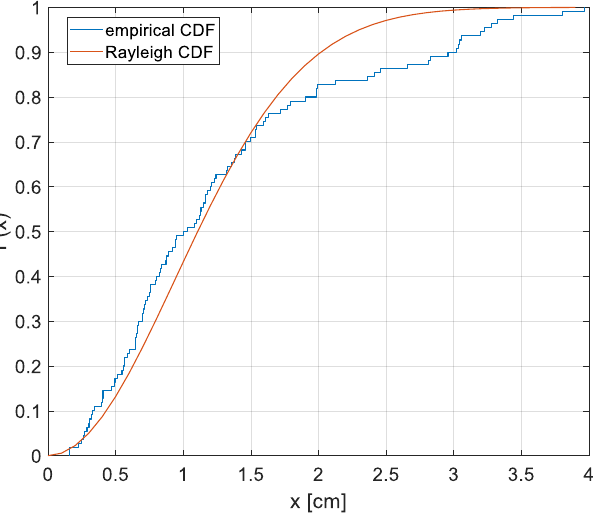
Figure 8. Empirical CDF F(x) of the positioning error (in blue) together with the CDF of a Rayleigh distribution; on the x -axis the positioning error in cm.